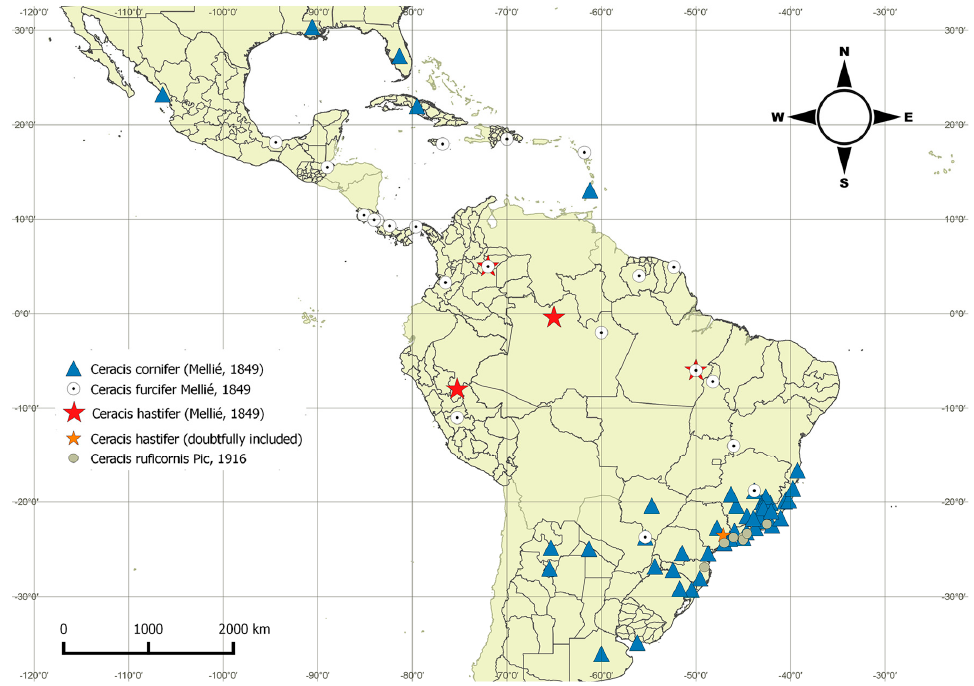
Figure 2. Distribution map for species of the furcifer group. The doubtful record of Ceracis hastifer (orange star) is based on individuals from São Roque (São Paulo (SP), Brazil). Note: the distribution of C. cornifer is disjunct. Overlapping symbols represent localities where two species are sympatric: C. cornifer and C. furcifer in Paranhos (Mato Grosso do Sul (MS), Brazil) and Serra do Cipó (MG, Brazil); C. furcifer and C. hastifer in San Luis de Palenque (Casanare, Colombia) and Marabá (Pará (PA), Brazil); and C. ruficornis and C. cornifer in Paraty (Rio de Janeiro (RJ)), Ilha da Vitória (SP) and Peruíbe (SP), Southeast Brazil.